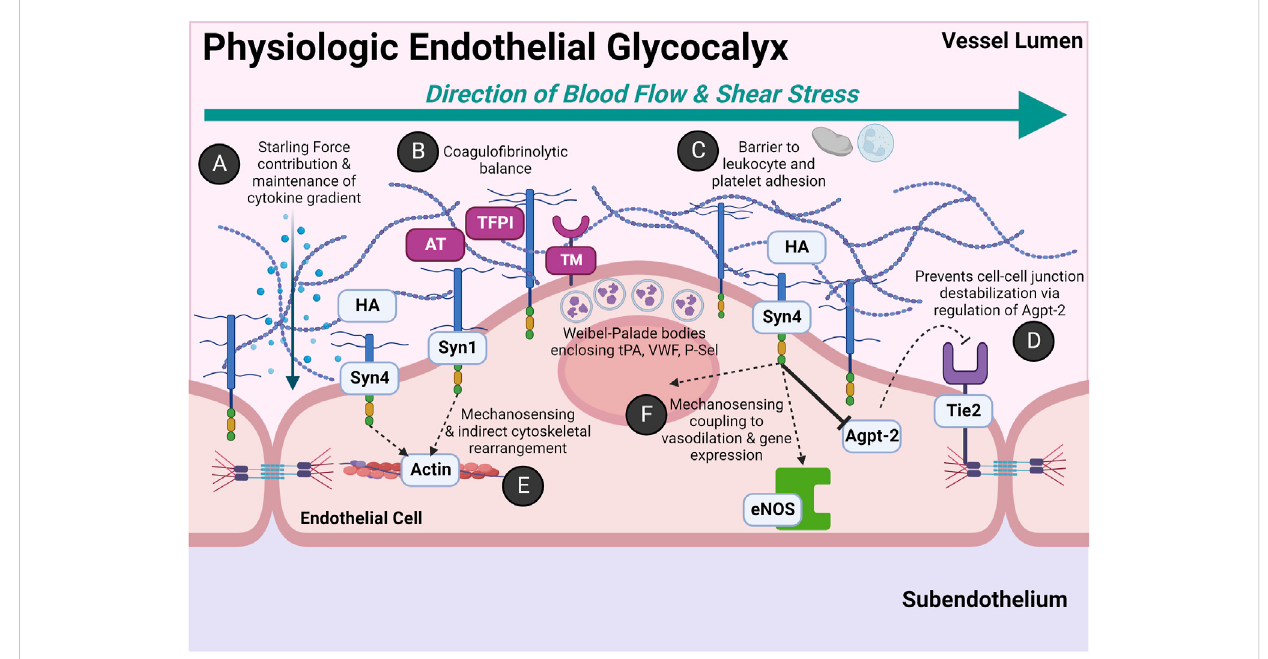
FIGURE 2 Physiologic Roles of the Endothelial Glycocalyx: An Anti-thrombogenic and Anti-adhesive Surface with Rapid Stress-sensing Capability. The glycocalyx is comprised of heparan sulfate proteoglycans (HSPGs) and glycosaminoglycans (GAGs). The HSPGs include the four transmembrane syndecans(Syn1-Syn4)andglypican.TheprimaryGAGsincludeheparansulfate(HS)andhyaluronan(HA).HSaccountsfor~50%oftheGAGcomposition in the glycocalyx and covalently bonds to the Syn family and glypican. Other GAGs not pictured include keratan sulfate, dermatan sulfate, and chondroitin sulfate. (A) The negatively charged, hydrophilic moieties of HS and HA have variable cleavage lengths and post-translational modi fi cations which confer signi fi cant degrees of speci fi city for binding cytokines and chemokines. This moderates oncotic and hydrostatic contributions of Starling Forces. Additionally, this creates a gradient of growth factors and signaling molecules which can be indirectly altered by constitutive or stress-induced transientchangesinHSPGandGAGcompositioneitherbyincreasedsynthesisorenzymaticcleavage. (B) Theendothelialglycocalyxmaintainsagradient of endothelial-synthesized anticoagulant coagulo fi brinolytic mediators. In addition to HS, antithrombin III (AT) and tissue factor pathway inhibitor (TFPI) areconstitutively expressed intheendothelial glycocalyx.AT complexes with HSto inactivate manycoagulationfactors,primarily thrombin andFactor X. The anticoagulant TFPI complexes with and inactivates tissue factor (TF)-FVII complex and prothrombinase complex (FVa-FXa). The endothelium also constitutively expresses membrane-bound receptor thrombomodulin (TM), which in the presence of its ligand thrombin, activates circulating plasma protein C. Activated protein C inactivates circulating Factors V and VIII and also inhibits the anti- fi brinolytic, plasminogen activator inhibitor-1 (PAI-1). Weibel-Palade bodies (WPB) also play a signi fi cant role in coagulo fi brinolytic balance, particularly for the activated endothelium (e.g., by endothelial agonistssuchascirculatingplasmaepinephrine).SeminalhemostaticmediatorsinWPBincludetissueplasminogenactivator(tPA),vonWillebrandFactor (VWF),andP-selectin(P-Sel). (C) Theglycocalyxservesasaphysicalbarriertoleukocyteandplateletadhesionintheeventadhesionmoleculeexpression is induced on the endothelial luminal surface (e.g., P-selectin, ICAM-1, VCAM-1). (D) Syn4 via intracellular syntenin and synectin indirectly regulates angiopoietin-2 (Agpt-2) activity. High Agpt-2 levels antagonize the tyrosine kinase receptor Tie2, which subsequently destabilizes endothelial cell-cell junctions. Agpt-2 may also be found in WPBs. (E) Syn1 and Syn4 transcellularly signal luminal shear stress to rearrange the endothelial cytoskeleton. (F) Shear stress signaling by the intracellular domain of Syn4 also induces vasodilation via activation of endothelial nitric oxide synthase (eNOS). Shear stress also increases nuclear expression of genes such as those implicated in in fl ammation. For example, increased shear stress has shown to induce VCAM-1 and ICAM-1 expression.(Lindahl etal., 1998;Kolá ř ová etal.,2014;Rayahin et al.,2015;Leligdowiczetal., 2018;Richter andRichter,2019;Woodcock and Michel, 2021; Neubauer and Zieger, 2022). Abbreviations: Agpt-2, Angiopoietin-2; AT, Antithrombin III; eNOS, Endothelial Nitric Oxide Synthase; HA, Hyaluronan; Syn1, Syn4, Syndecan; TFPI, Tissue Factor Pathway Inhibitor; Tie2, tyrosine kinase receptor Tie2; TM, Thrombomodulin. Created with